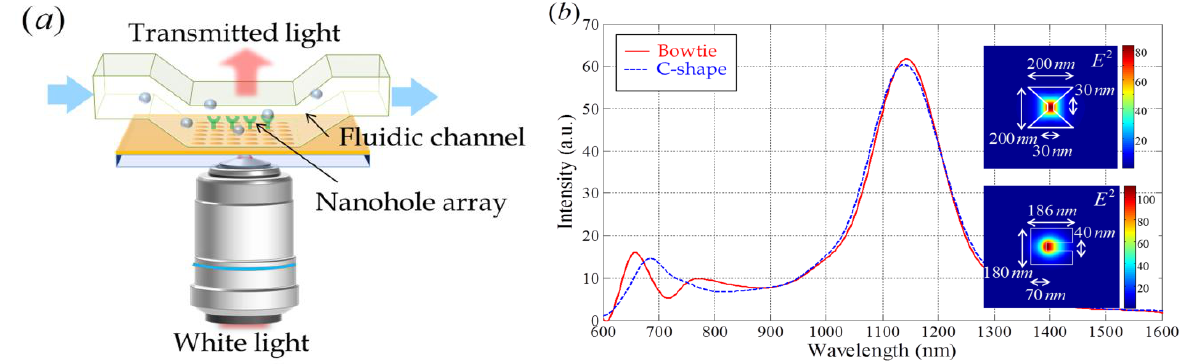
Figure 8. (a) Scheme for an EOT based sensor system with a periodic nanohole array in a metallic layer. (b) Transmission spectrum through single nanohole apertures – bowtie and C-shaped nano-apertures. The inset figures represent intensity distribution at a distance of 20 nm from each single